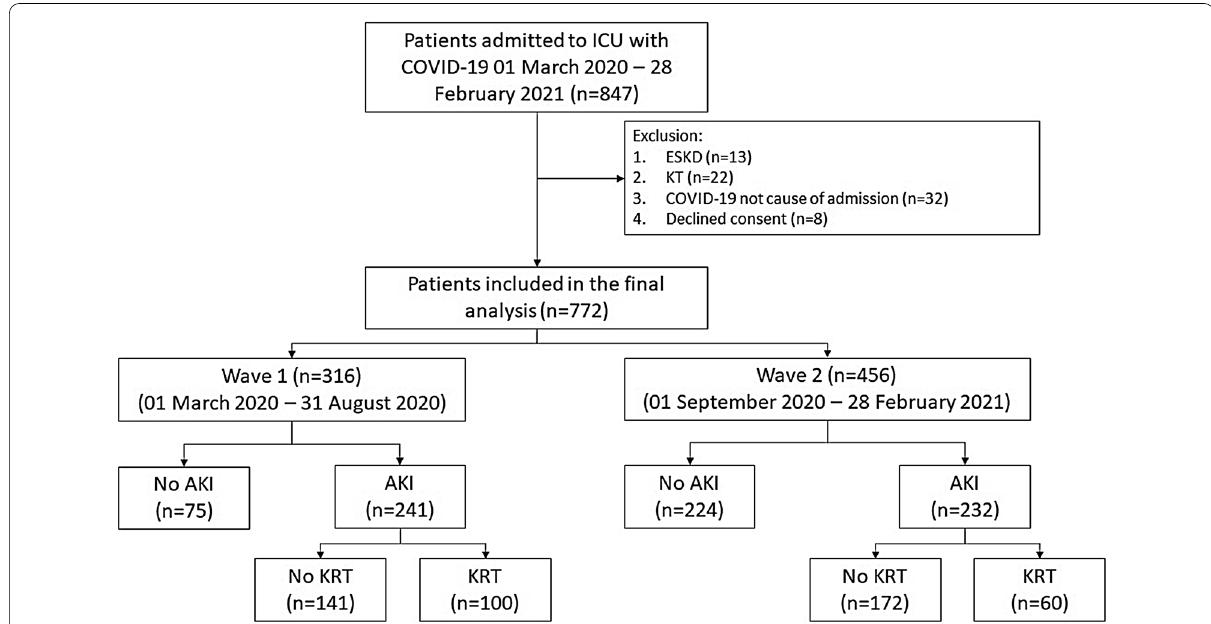
Fig. 1 Study flowchart. ICU intensive care unit, ESKD end-stage kidney disease, KT kidney transplantation, AKI acute kidney injury, KRT kidney replacement